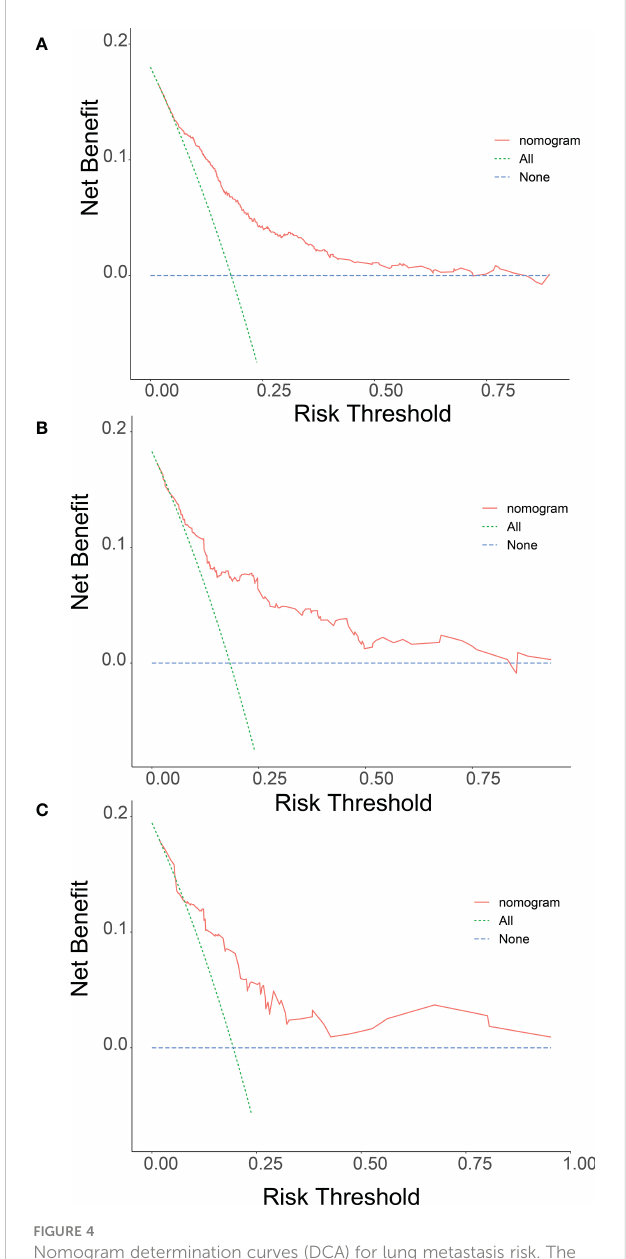
FIGURE 4 Nomogram determination curves (DCA) for lung metastasis risk. The red curve (number at high risk) indicates the number of people classi fi ed as positive (high risk) for each threshold probability for the Nomogram. The green curve (number at high risk with outcome) indicates the number of true positives at each threshold probability ( A training group, B internal validation group and C multicentre validation